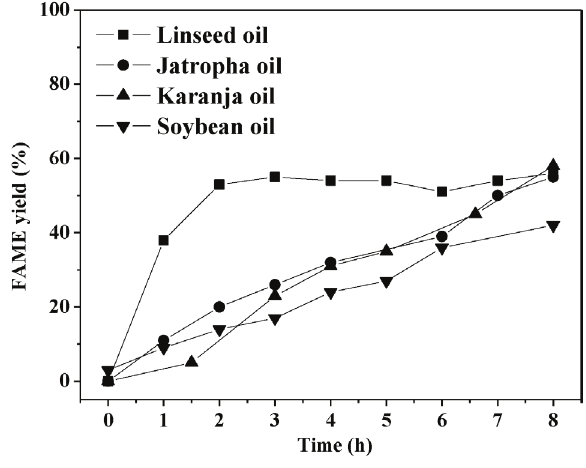
Fig. 3 – FAME yield at different reaction times for different oils. Reaction conditions: oil = 89.26 g; methanol:oil = 60:1; catalyst amount = 18 wt% of oil; T = 393 K; reaction mixture volume = 341